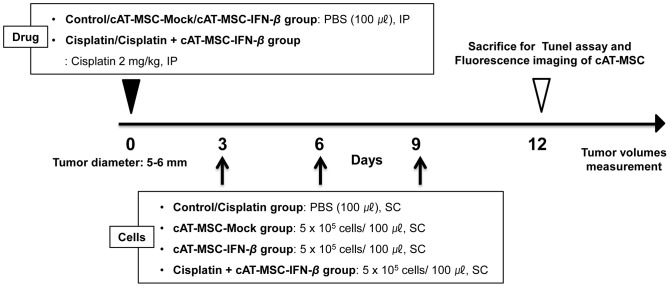
Time schedule for tumor therapy in the animal experiments.After tumor induction with LMeC melanoma cells (5×106 cells), mice were randomly divided into five groups. The control group was treated with a circumtumoral injection of phosphate-buffered saline (PBS) (n = 4). The cisplatin and combination group were treated with intraperitoneal injection of low-dose cisplatin (2 mg/kg) (n = 4). The cAT-MSC-Mock, cAT-MSC-IFN-β and combination group were treated with a circumtumoral injection of each cAT-MSCs (5×105) in PBS 3 times at 3 days interval. The size of each mass was measured every 3 days. Three days after the last injection, mice were sacrificed and tumor tissue was harvested for fluorescence microscopy analysis.